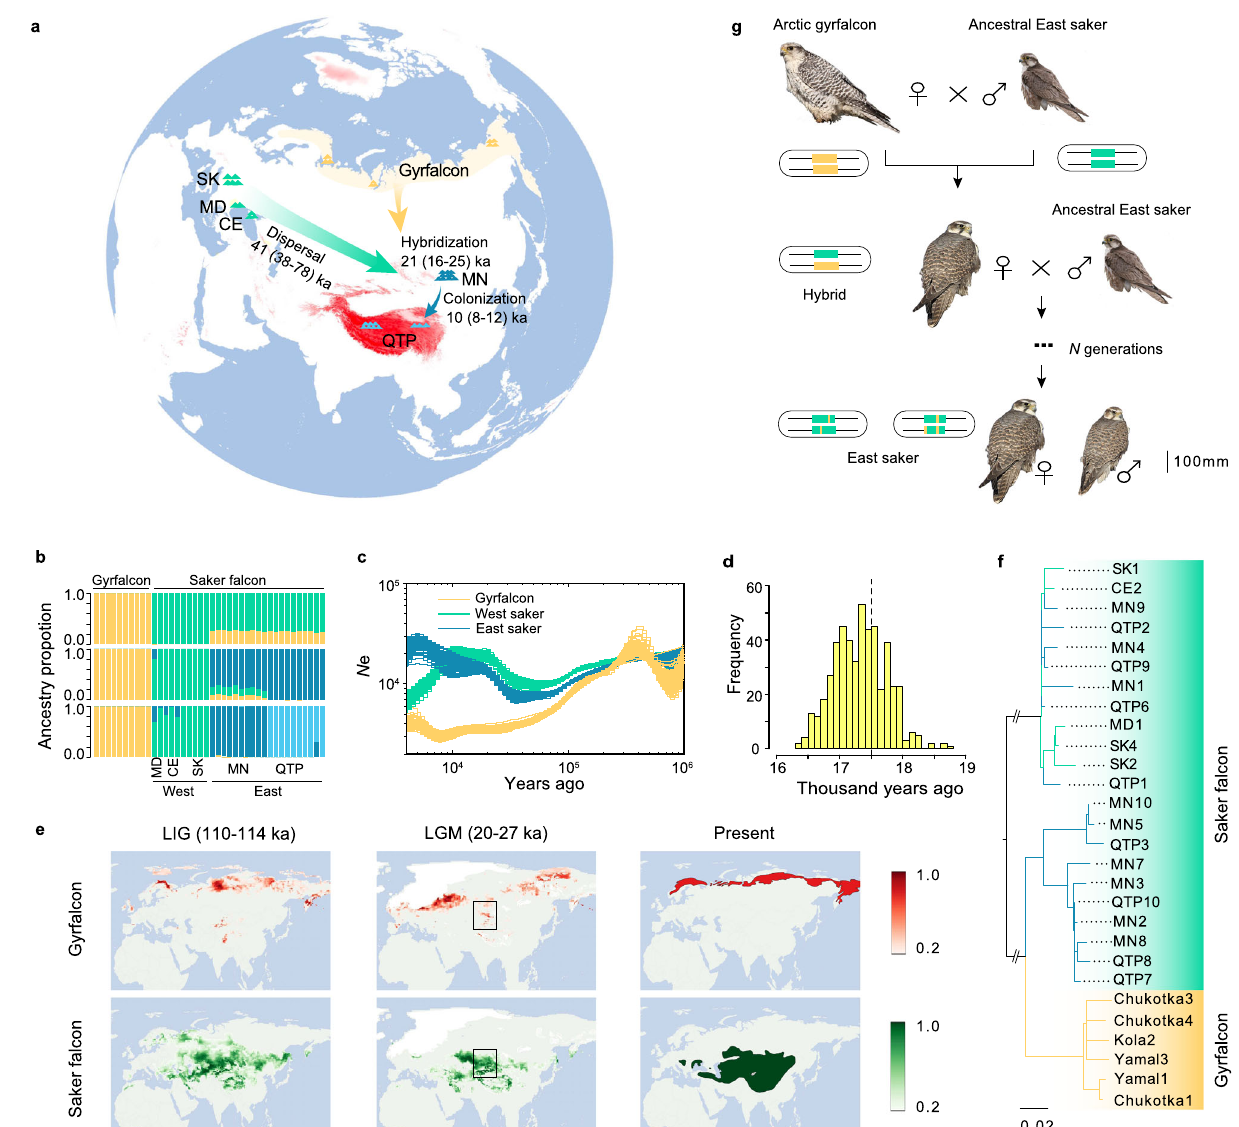
Fig. 1 | Stepwise colonization of saker falcons onto the Qinghai-Tibet Plateau. a Samplinglocalitiesforsakersandgyrfalconsandthecolonizationrouteofsakers. SK Slovakia, MD Moldova, CE Crimea, MN Mongolia, QTP Qinghai-Tibet Plateau. b Population structure of falcons ( K =2-4). c Demographic histories for both spe- cies ( μ =1.1E – 08, g =6.6 years). d Introgression time estimation (500 bootstraps). The dashed line shows the estimated maximum likelihood time. e Simulation of potential breeding areas with suitable climate for sakers and gyrfalcons in the last interglacial(LIG)andlastglacialmaximum(LGM).Therectanglesshowoverlapped